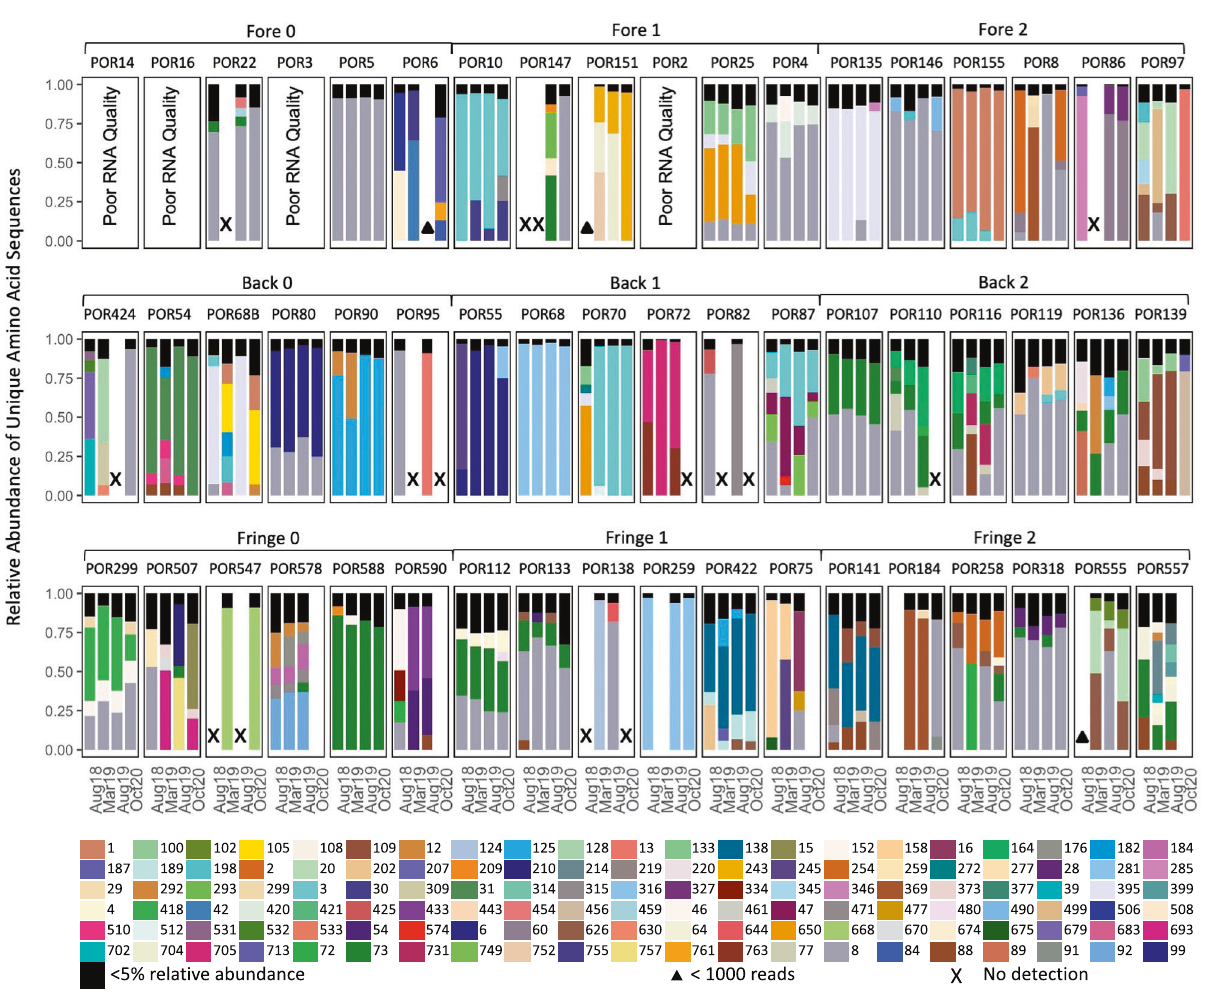
Fig. 4 Relative abundance of unique amino acid sequences ( ‘ aminotypes ’ ) detected in Porites lobata-Cladocopium C15 holobionts from coral reefs of Moorea, French Polynesia (South Paci fi c). Each set of four bars represents one colony sampled over time (numerical colony ID above box); colonies are grouped by reef zone (rows) and sites (sequentially ordered across each row). Aminotypes comprising less than 5% relative abundance within a sample are depicted together in black at the top of vertical bars. All other colors represent distinct aminotypes. Triangles indicate positive dinoRNAV detection, but poor sequencing success (<1000 reads); X indicates no detection. Blank space (no symbol) indicates that a sample does not exist for a given time